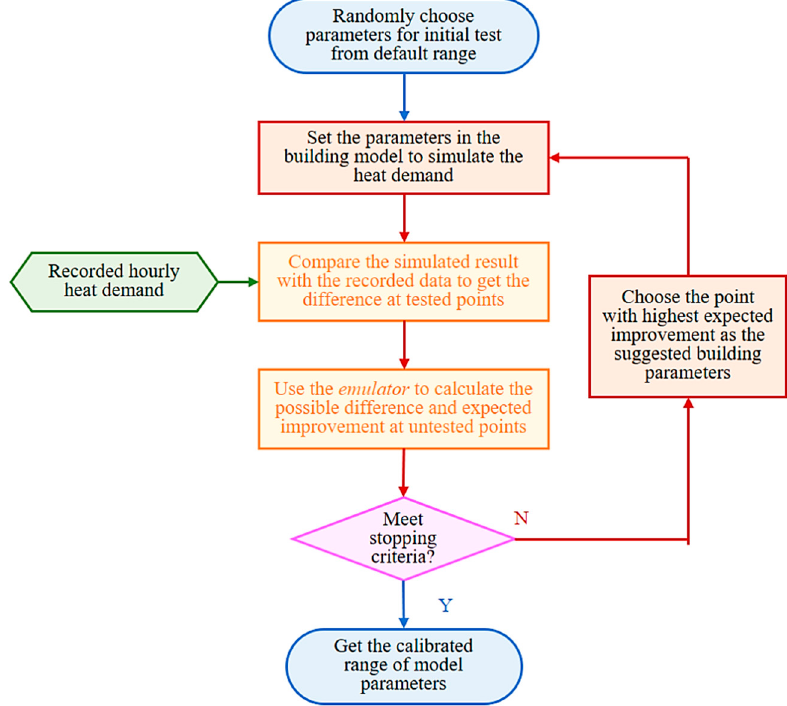
Figure 3. Flow chart of history matching calibration approach.